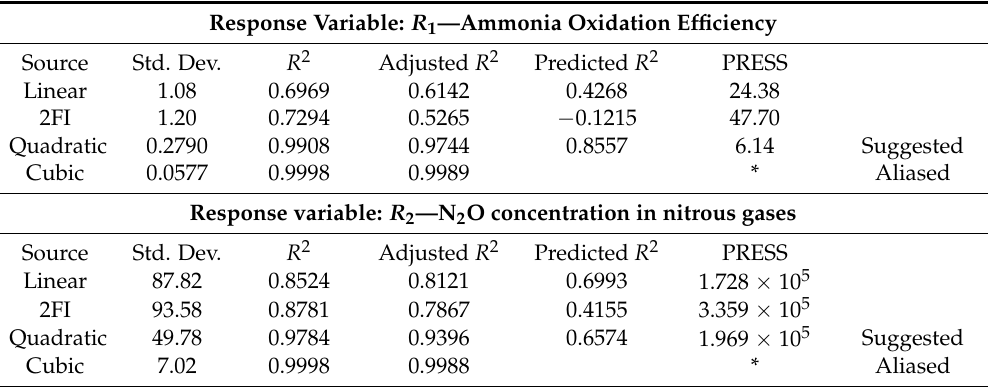
Table 2. Model summary statistics for response variables R 1 and R 2